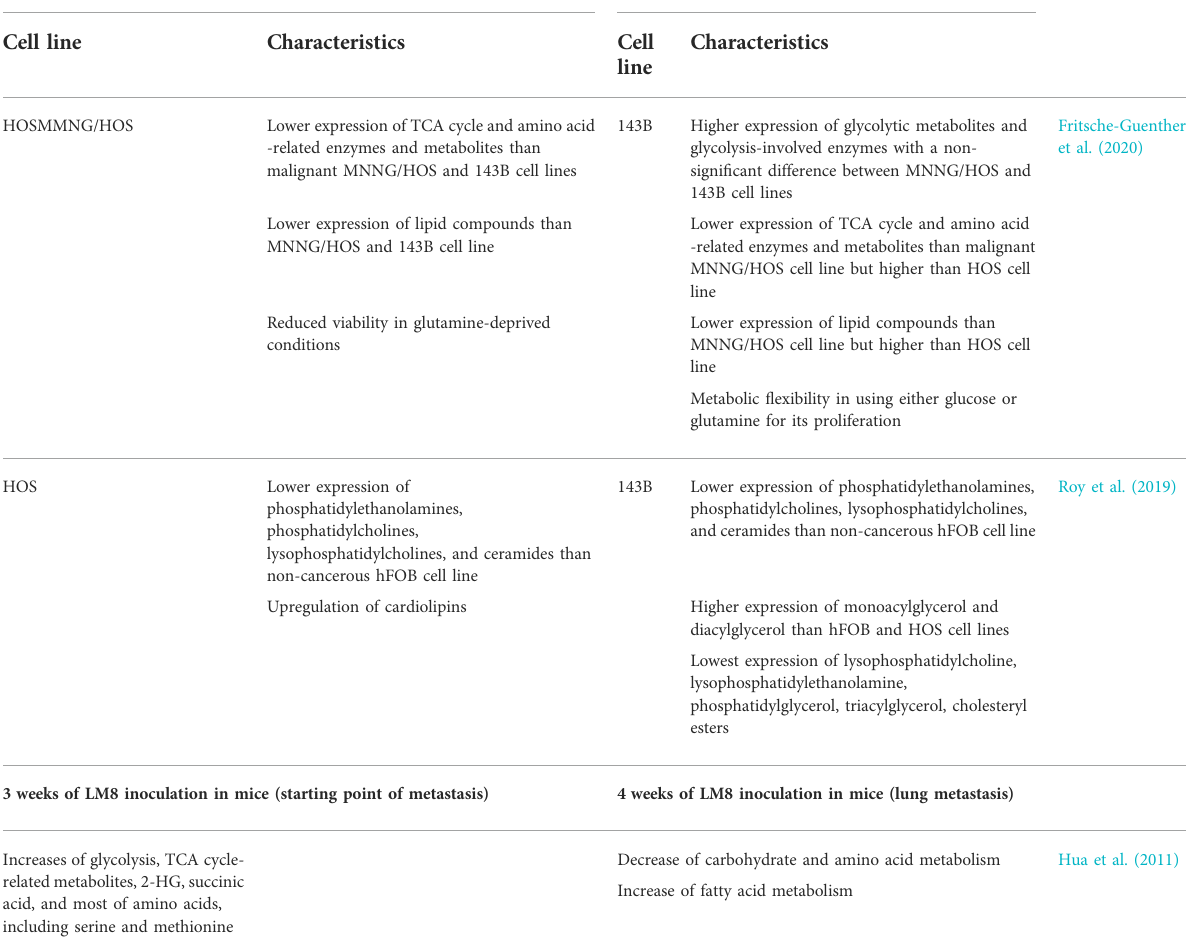
TABLE 2 Metabolic reprogramming pro fi ling by omics- analysis in